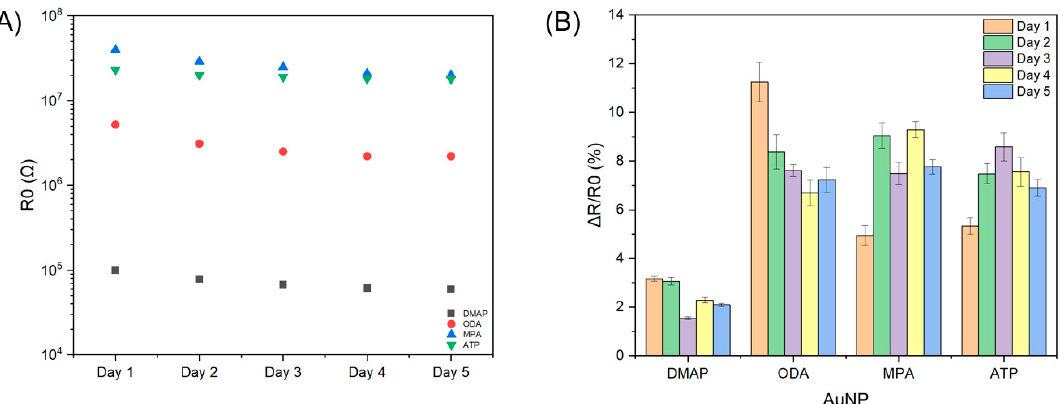
Figure 6. ( A ) Baseline resistance of four sensor elements with different monolayer protected nanoparticles on the same chip during a five-day experiment. ( B ) Sensing responses toward Irish Breakfast Tea.